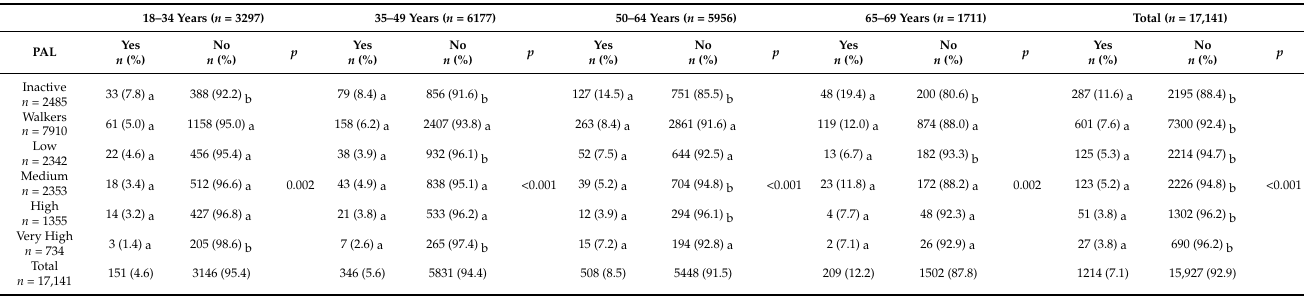
Table 4. Associations between the hospitalisation prevalence and physical activity level in the general Spanish population aged 18–69 years compared by age, according to the ENSE